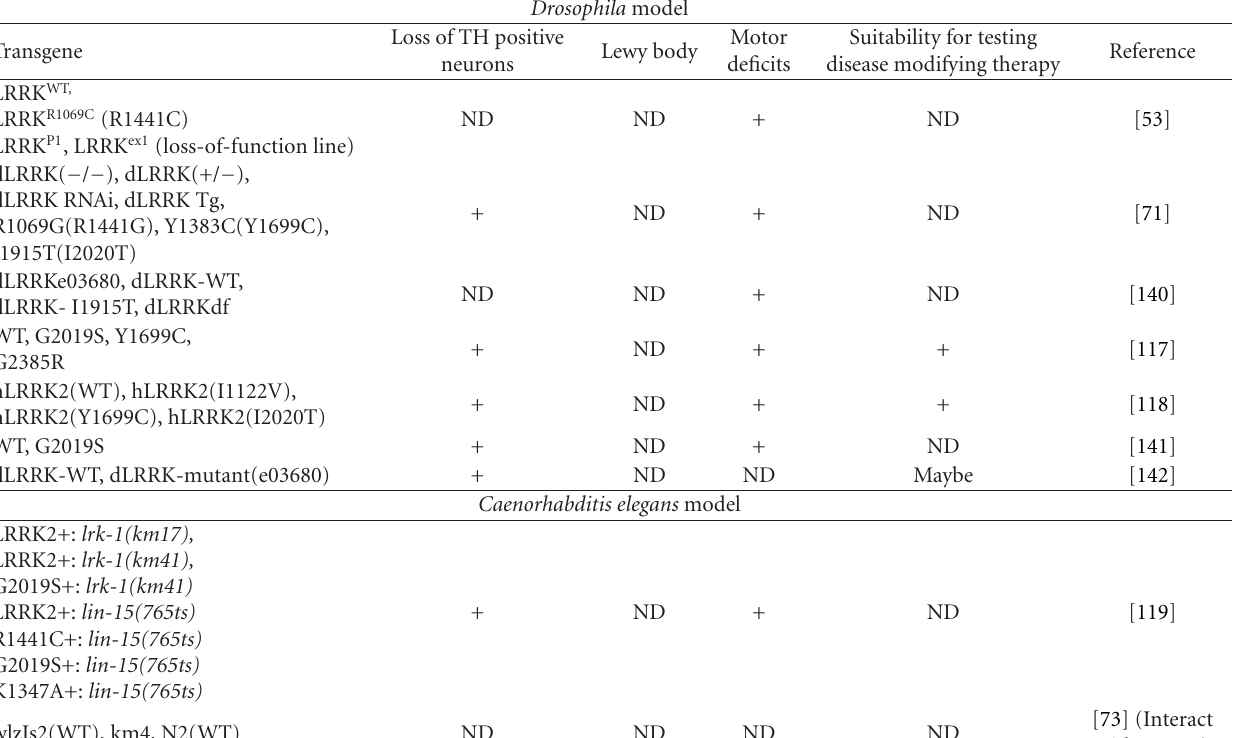
Table 3: LRRK2 animal